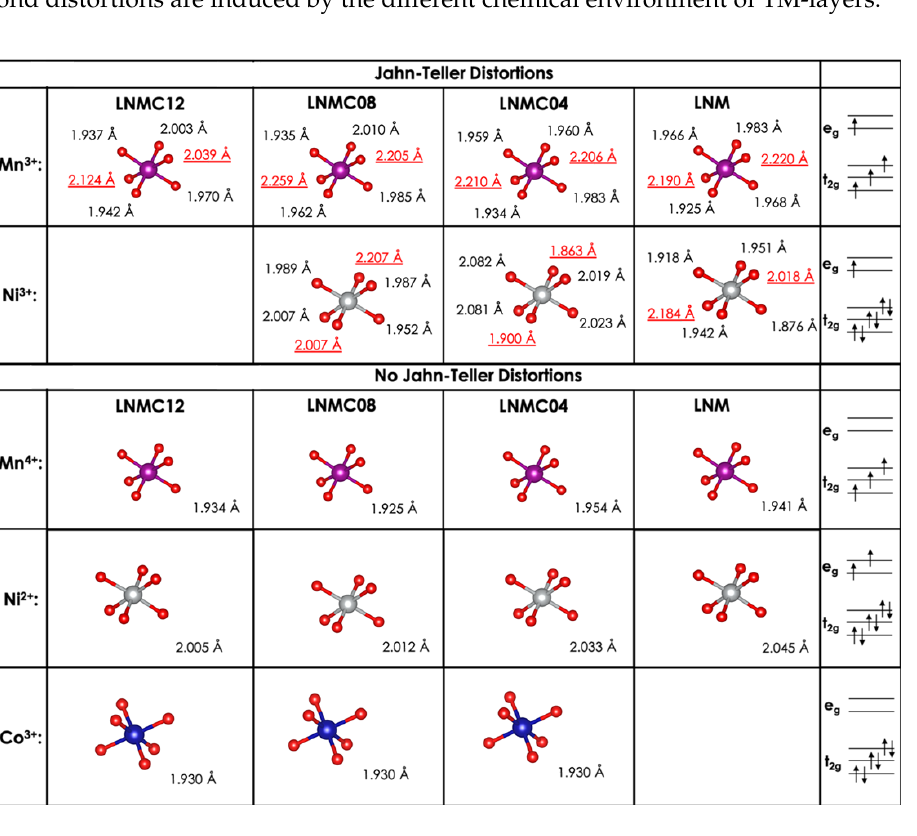
Figure 5. JT distorted and undistorted octahedra in LNMC12, LNMC08, LNMC04, and LNM super-